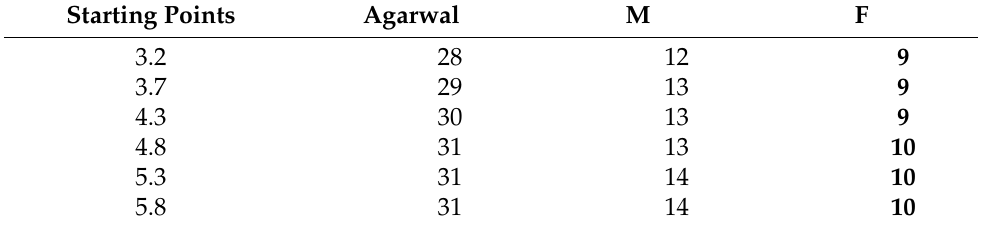
1 and β k = k . 7 k + 9 ( 3 k + 5 ) 1 5 Number of Iterates for Obtaining Fixed